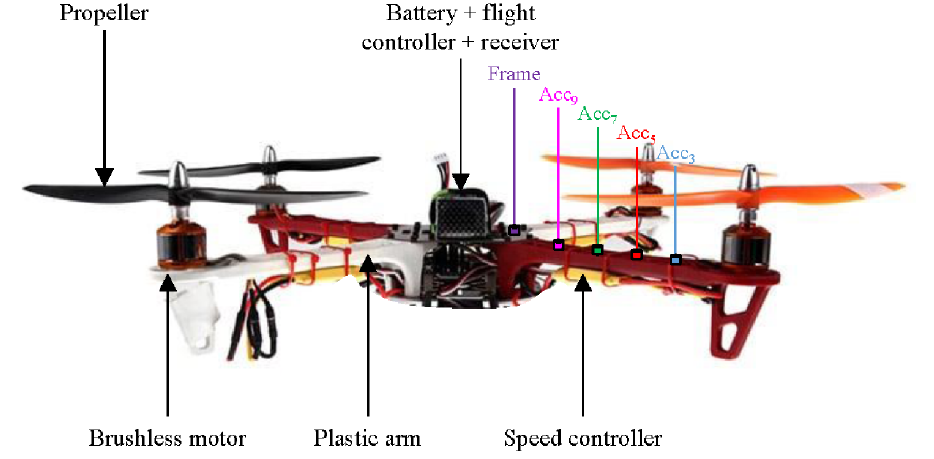
Fig. 1. Picture of a DJI F450 drone and its